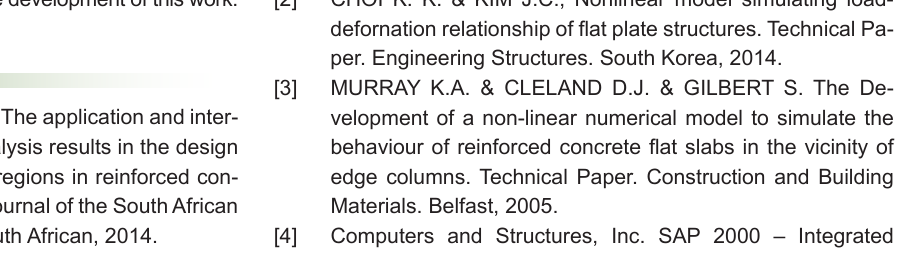
Figure 36 – Section 1 - Asymmetrical flat slab – Case 3.2 – Direction X